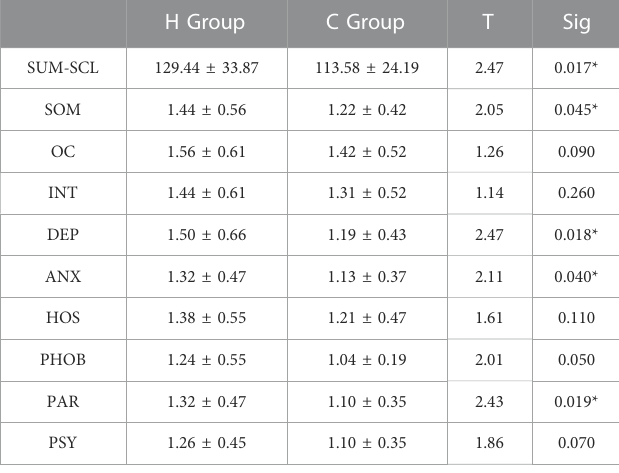
TABLE 4 The SCL-90 scores of women in both the groups after long-term heat exposure (Mean ± SD). H Group C Group T Sig